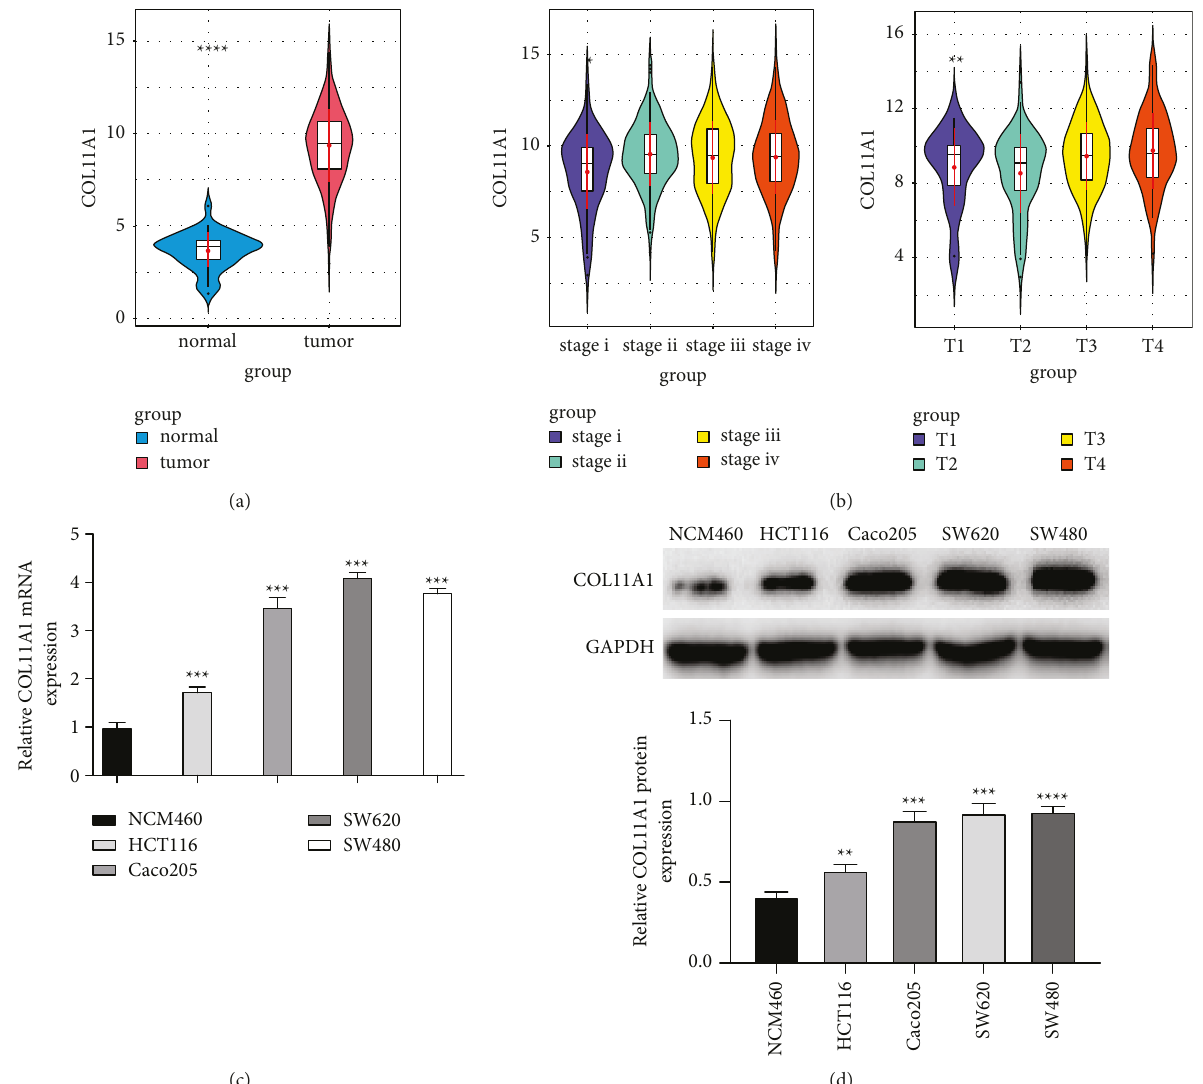
Figure 1: High level of COL11A1 in colon carcinoma. (a) COL11A1 expression differences in TCGA database. (b) COL11A1 expression in different clinical stages and T stages of colon carcinoma. ((c)-(d)) COL11A1 expression was upregulated in colon carcinoma cell lines ∗∗∗ p < 0 .